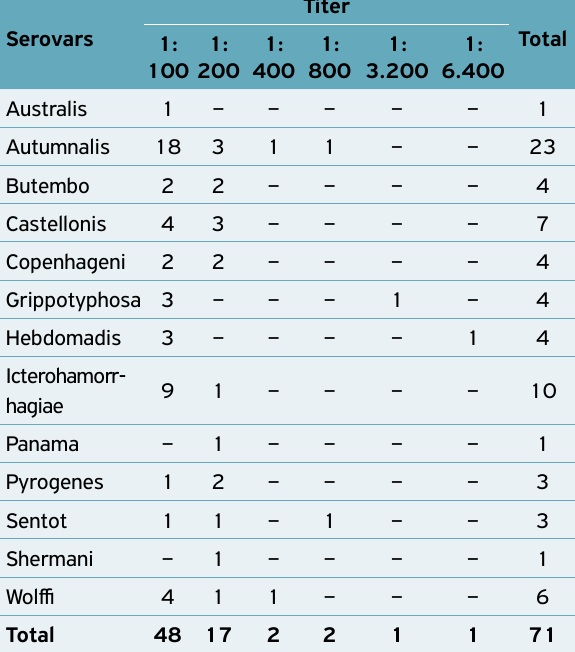
Table 1. Distribution of Leptospira spp. serovars among sheep in Pernambuco state, Brazil.